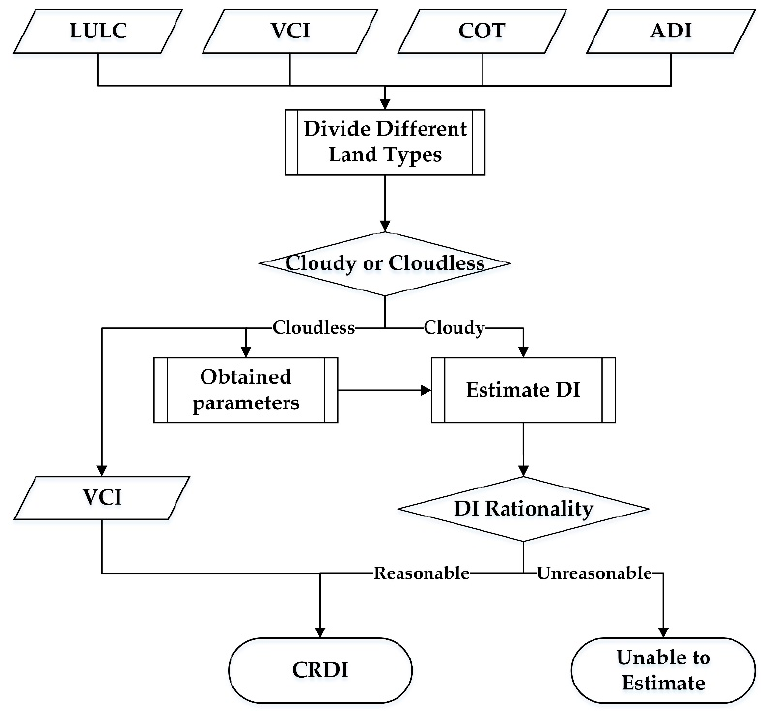
Figure 4. Flow chart of the calculation of a cloudy region drought index (CRDI).